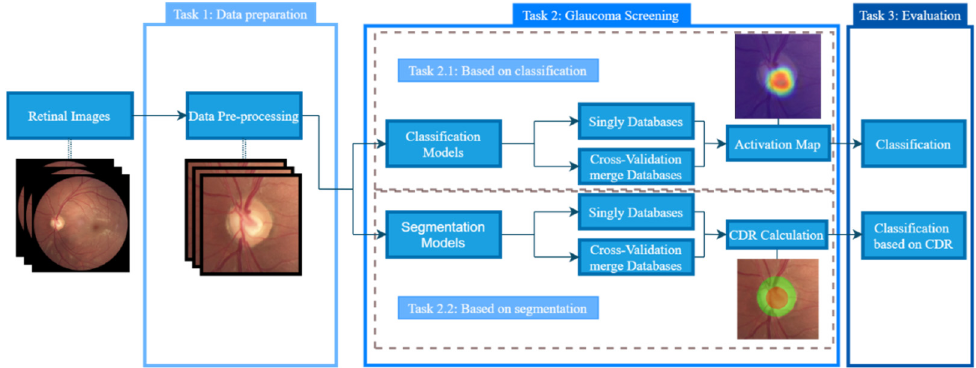
Figure 4. The model pipeline for glaucoma screening.